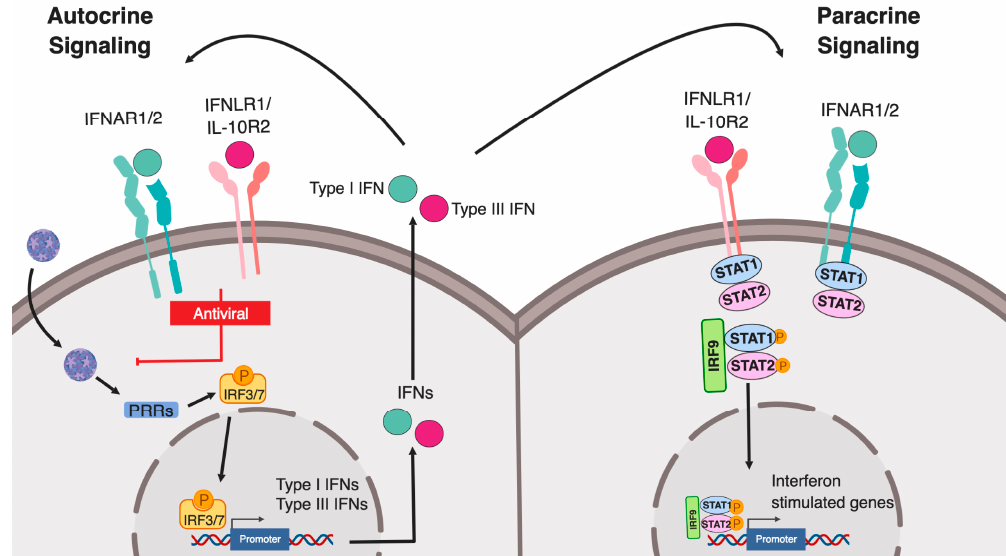
Figure 1. Type I and III interferon production following pathogen sensing. Schematic representing the canonical pathway of pathogen recognition receptor (PRR) sensing of intracellular pathogens. Pathogen associated molecular patterns (PAMPs) are recognized by PRRs leading to activation and phosphorylation of IRF3/7 which then translocate into the nucleus and drive the expression of both type I and III interferons. Both interferons are translated and secreted from the infected cell in an autocrine or paracrine manner. Upon binding of type I IFN to the IFNAR1/IFNAR2 and of type III IFN to the IFNLR1/IL-10R2 receptor, signal transductions are initiated leading to the formation of the ISGF3 complex (IRF9/p-STAT1/p-STAT2) which then acts as a transcription factor driving the expression of interferon stimulated genes.